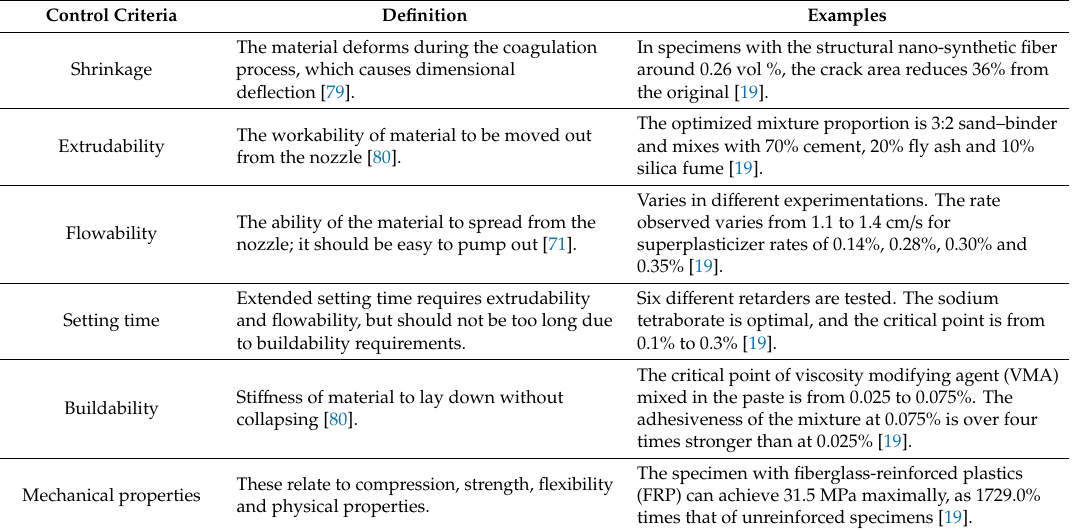
Table 7. Summary of criteria discussed in the literature and examples from the